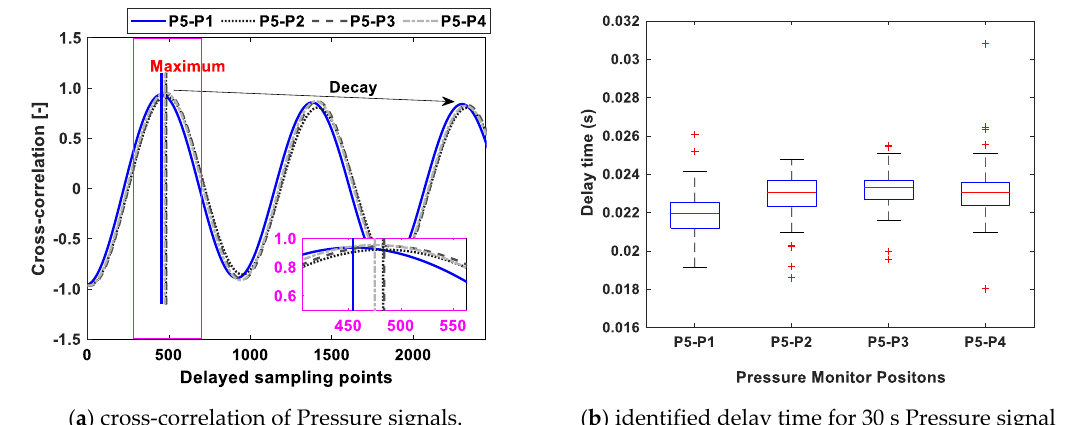
Figure 10. Stall mode identification and parameter characterization using cross-correlation analysis.